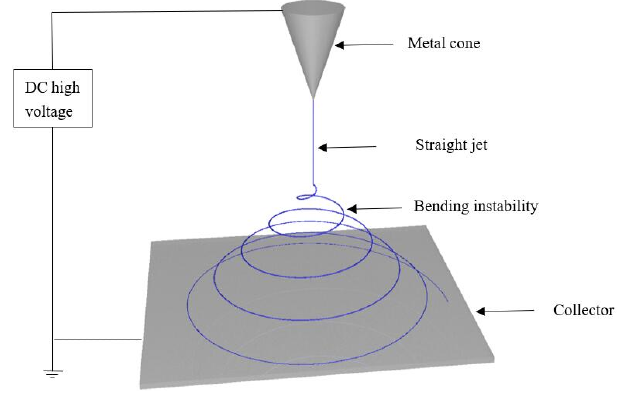
Figure 2. A simplified schematic of an electrospinning system.